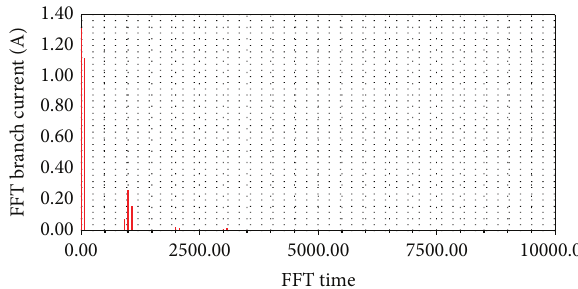
Figure 12: The FFT of DC link current (with LCL filter).